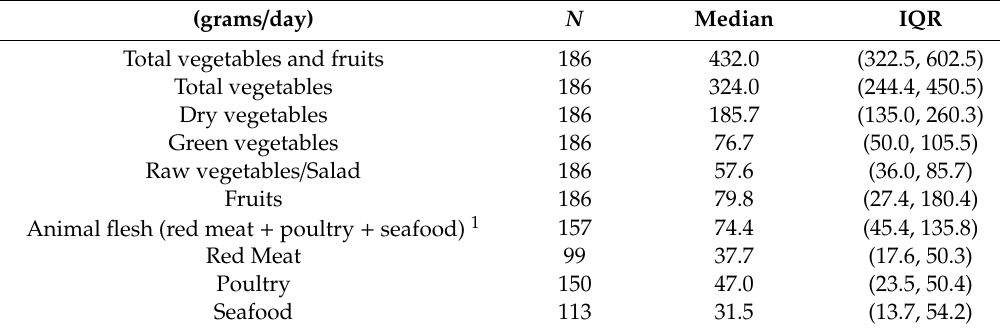
Table 2. Daily food groups intake of the study population.